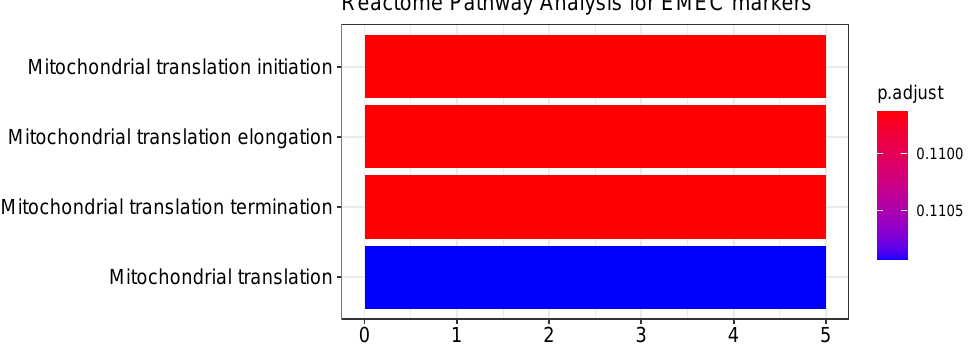
Figure 6. Top Reactome ontologies enriched for the EMEC gene signatures.